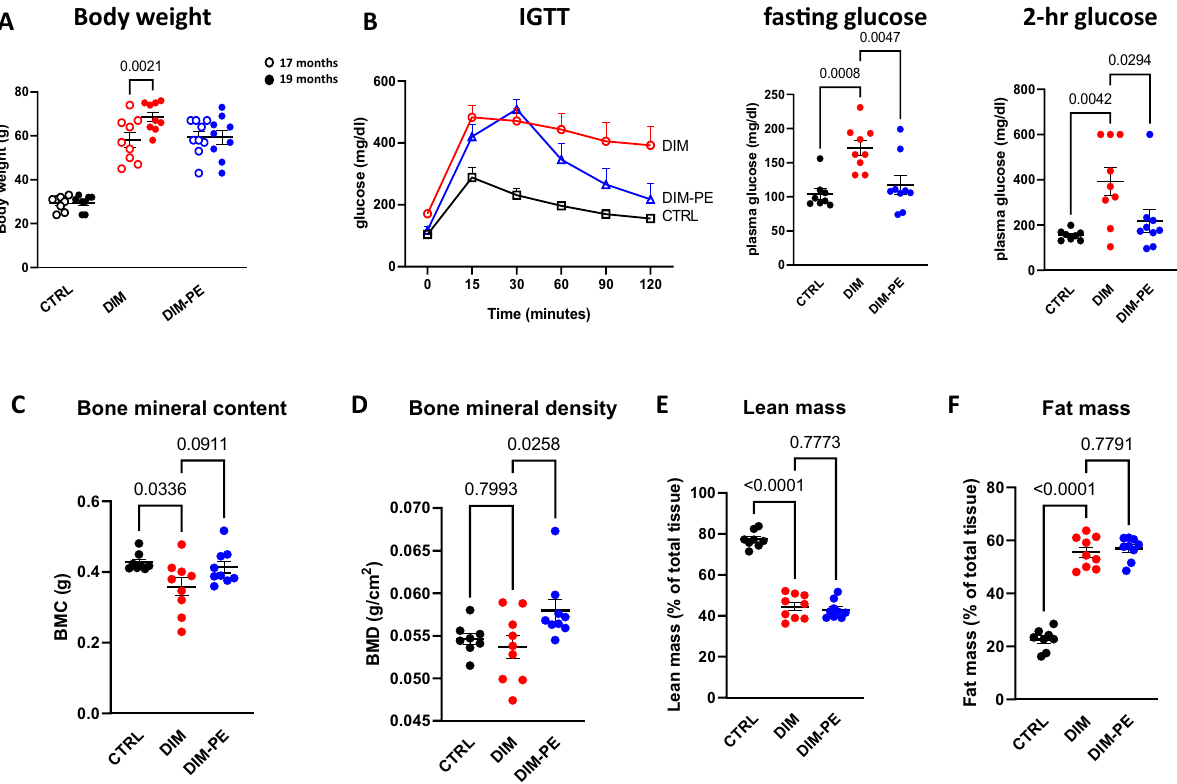
Figure 2. The effect of voluntary wheel-running on periphery glucose and bone health measurements of ( A ) Body weight, ( B ) glucose utilization: IGTT, fasting glucose and postprandial glucose in plasma, ( C – D ) Bone mineral content and bone mineral density, ( E – F ) Lean and fat mass following two months voluntary physical exercise. Data represents mean ± SEM, n = 8–9 per